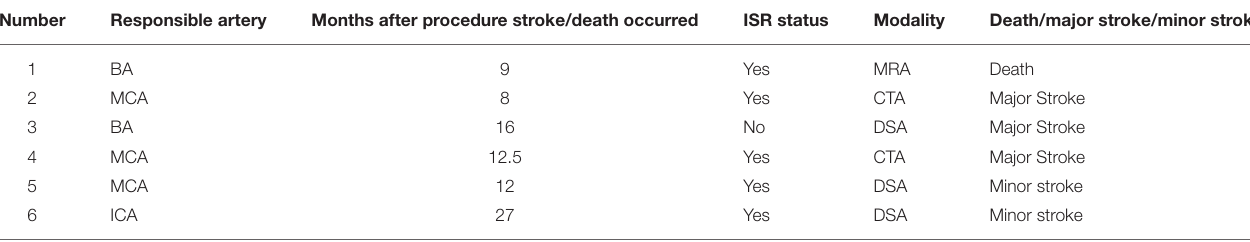
TABLE 2 | Stroke in the territory of the stented artery after 30 days.